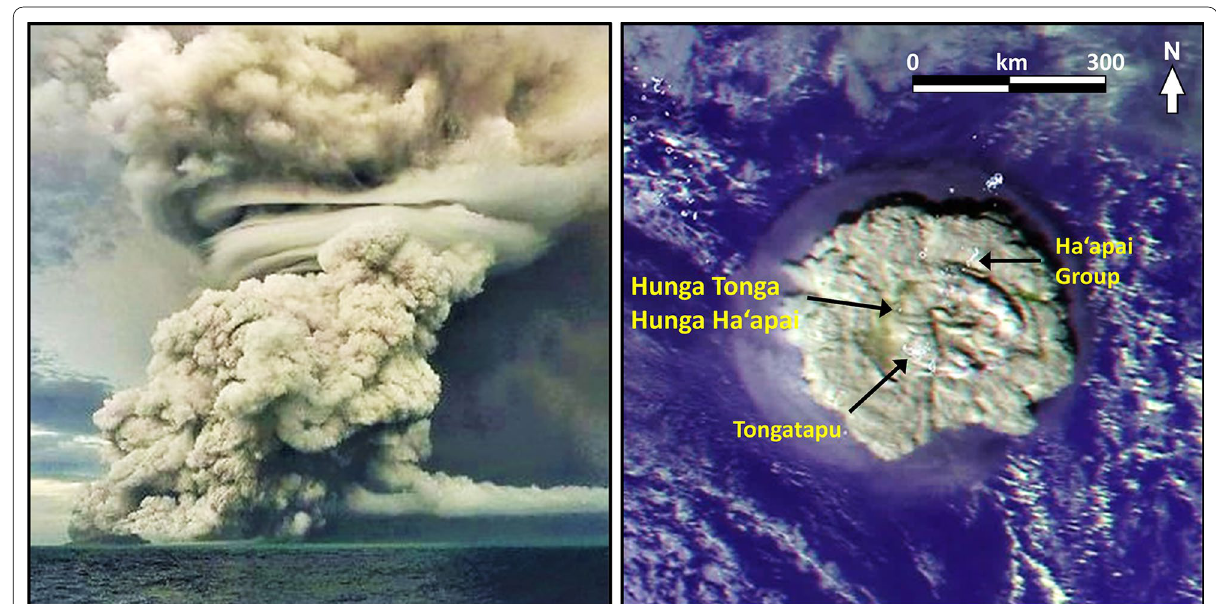
Fig. 3 Two significant eruptions of Tonga’s HTHH volcano. Left: Surtseyan-style eruption of 14 January 2022, sending a large ash and steam plume high into the troposphere. Image courtesy of the Tonga Geological Services. Right: major caldera eruption on 15 January 2022. Satellite view of the expanding plume ejected. Note the off-centre position of the volcano, indicating the relatively strong (south)eastward directionality of the outward plume expansion. The central dome of the plume reached a Mesospheric altitude of 58 km. The image was captured by the AGRI (Advanced Geostationary Radiation Imager) instrument at 1 km resolution, on board the Chinese satellite FY-4B. Information available at: https:// space. oscar. wmo. int/ satel lites/ view/ fy_ 4b. Data processed and provided by Dr. Hao Gao, China Meteorological